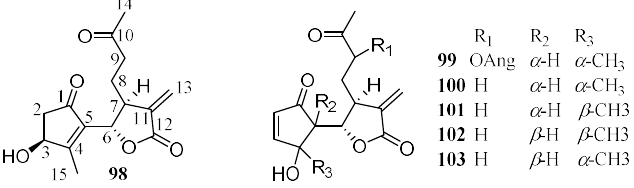
Figure 4. 1,10-Seco guaianolides from the Chrysanthemum genus.